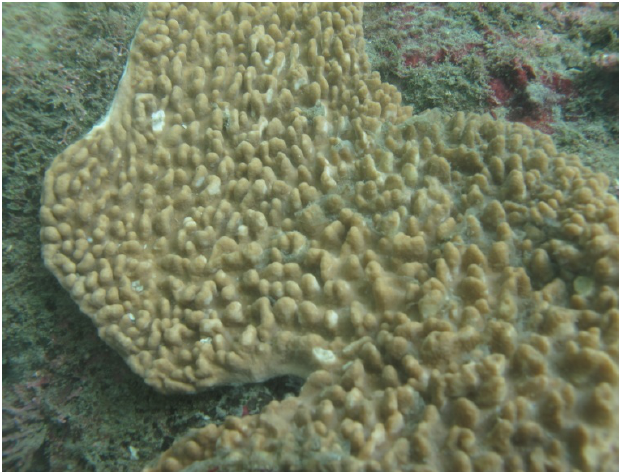
Figure 1. The soft coral Sinularia crassa .